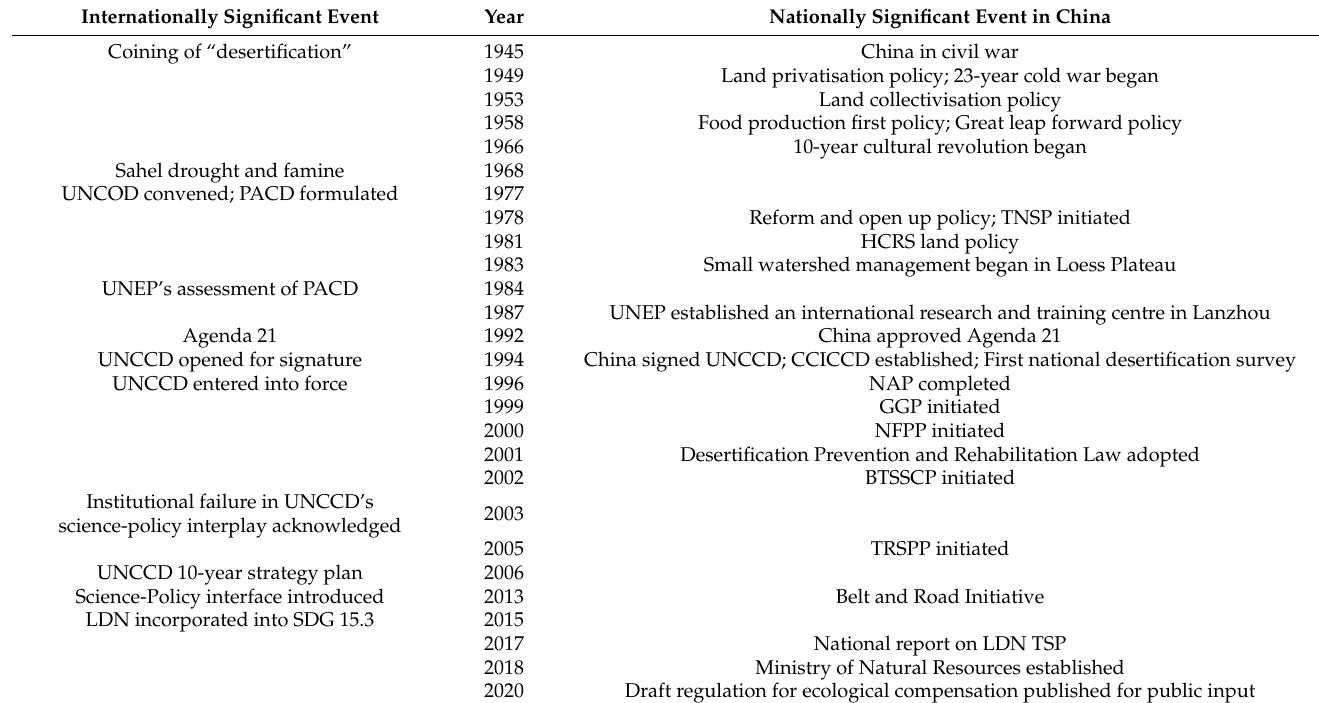
Table 2. Development stages of the UNCCD and China’s efforts relevant to combating desertification. Internationally Significant